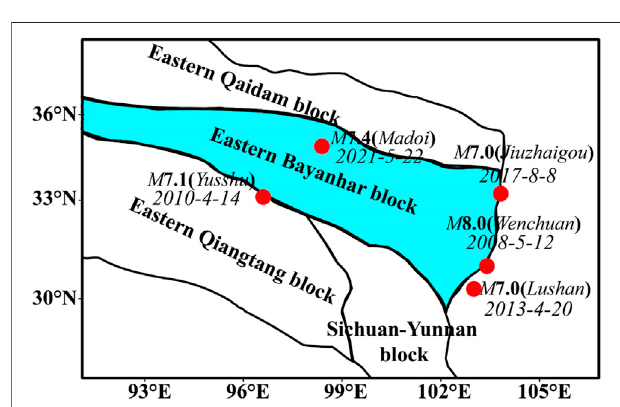
FIGURE 3 | Schematic map showing secondary tectonic blocks on the eastern margin of the Qinghai-Tibetan Plateau and the distribution of strong earthquakes after